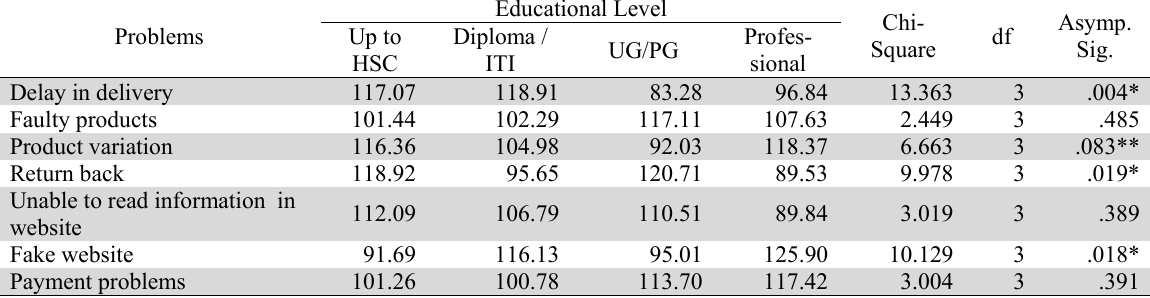
Results of Kruskal Wallis Test – Educational Level Vs Ranking of